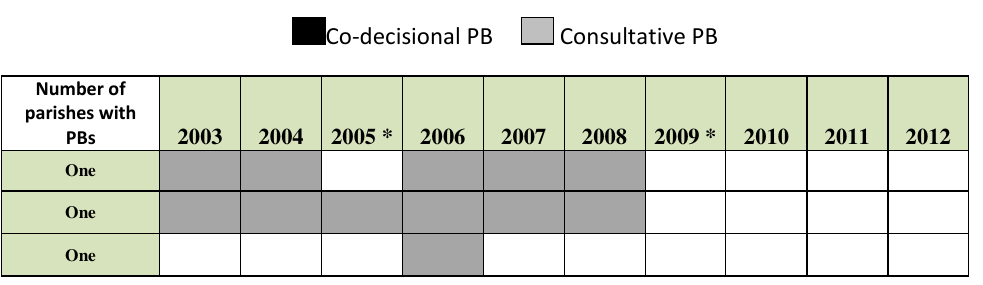
Continuum of Portuguese PB at parish/ freguesia level